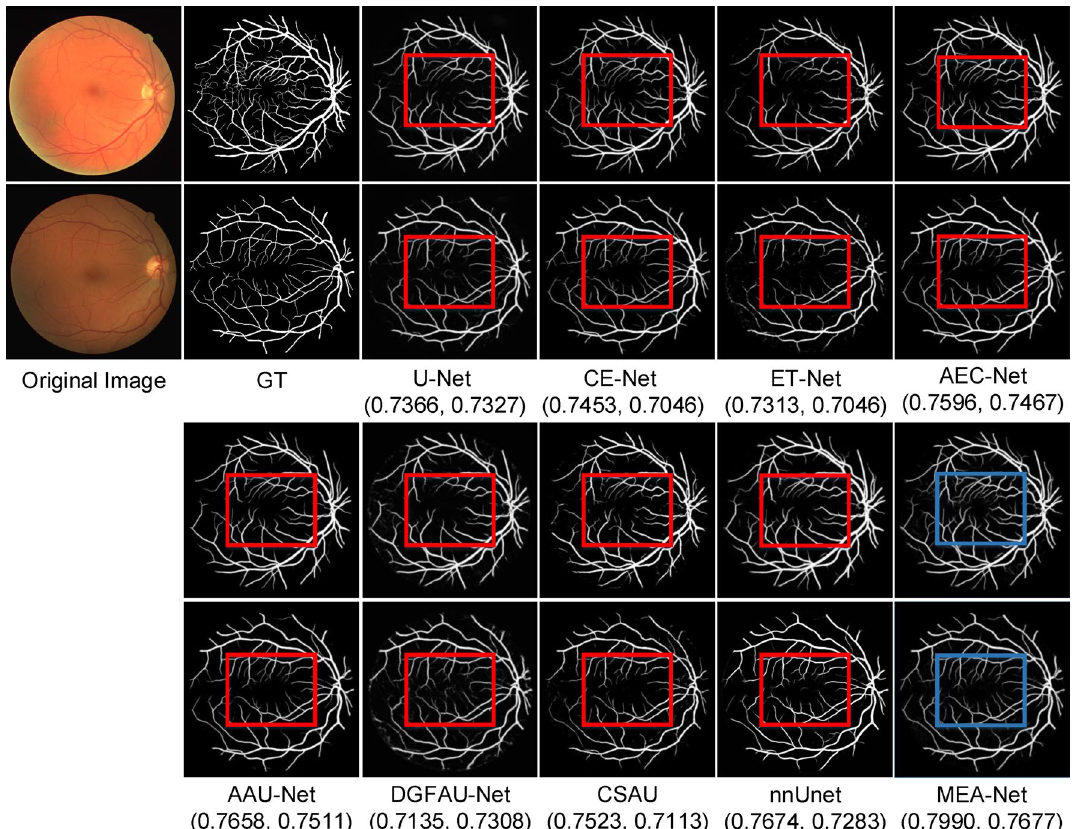
Figure 7. Sample results of DRIVE segmentation. (The Dice values for each legend are in